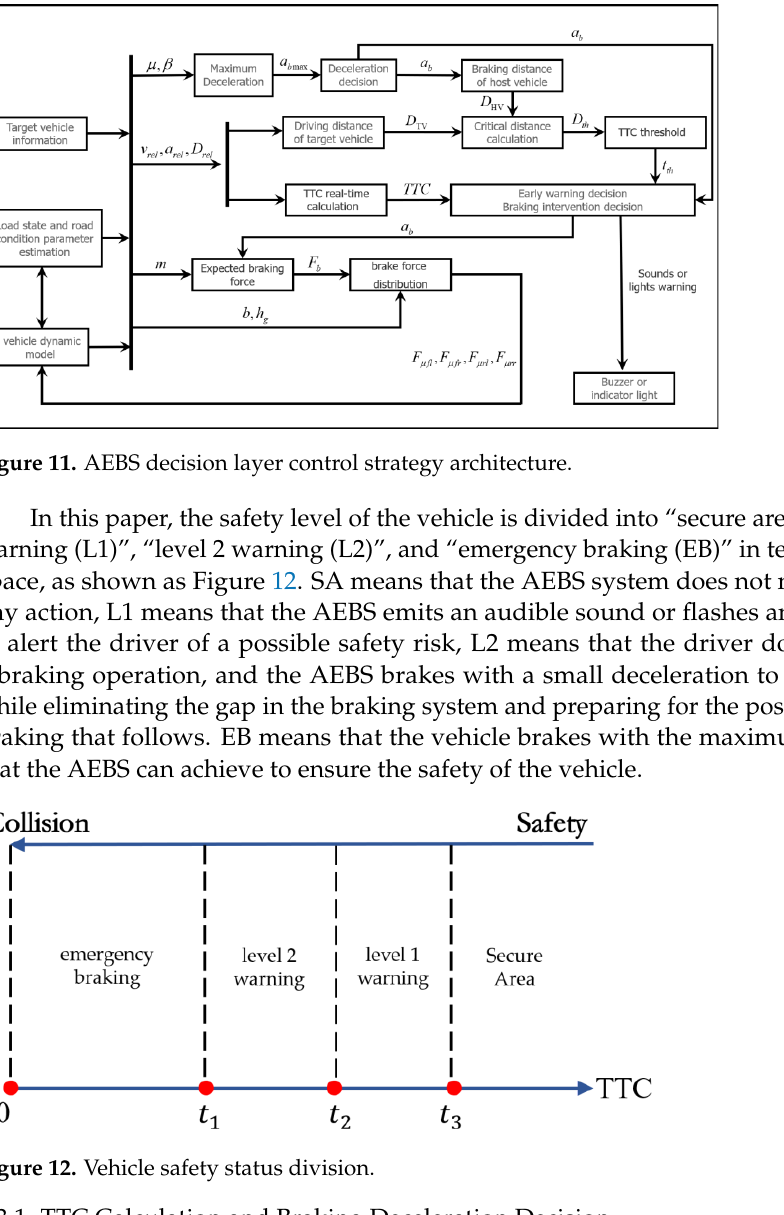
( c ) Figure 10. Tire-road friction coefficient estimation results. ( a ) Estimation results for μ = 0.4; ( b ) esti- mation results for μ = 0.6; ( c ) estimation results for μ = 0.8. Table 5. Tire-road friction coefficient estimation results. True Value